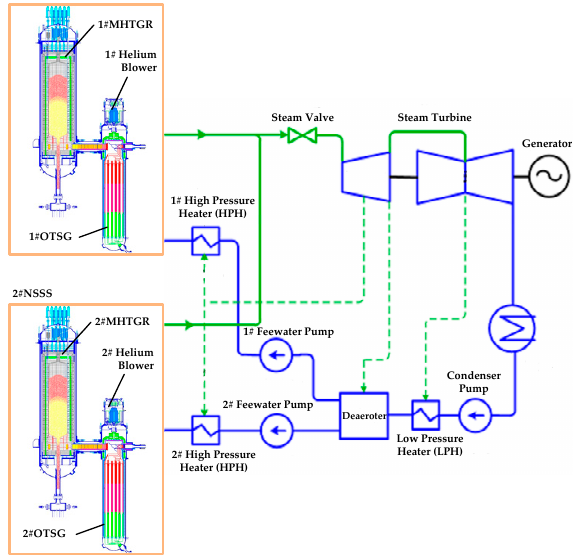
Figure 4. Schematic diagram of the high temperature reactor (HTR)-PM plant.